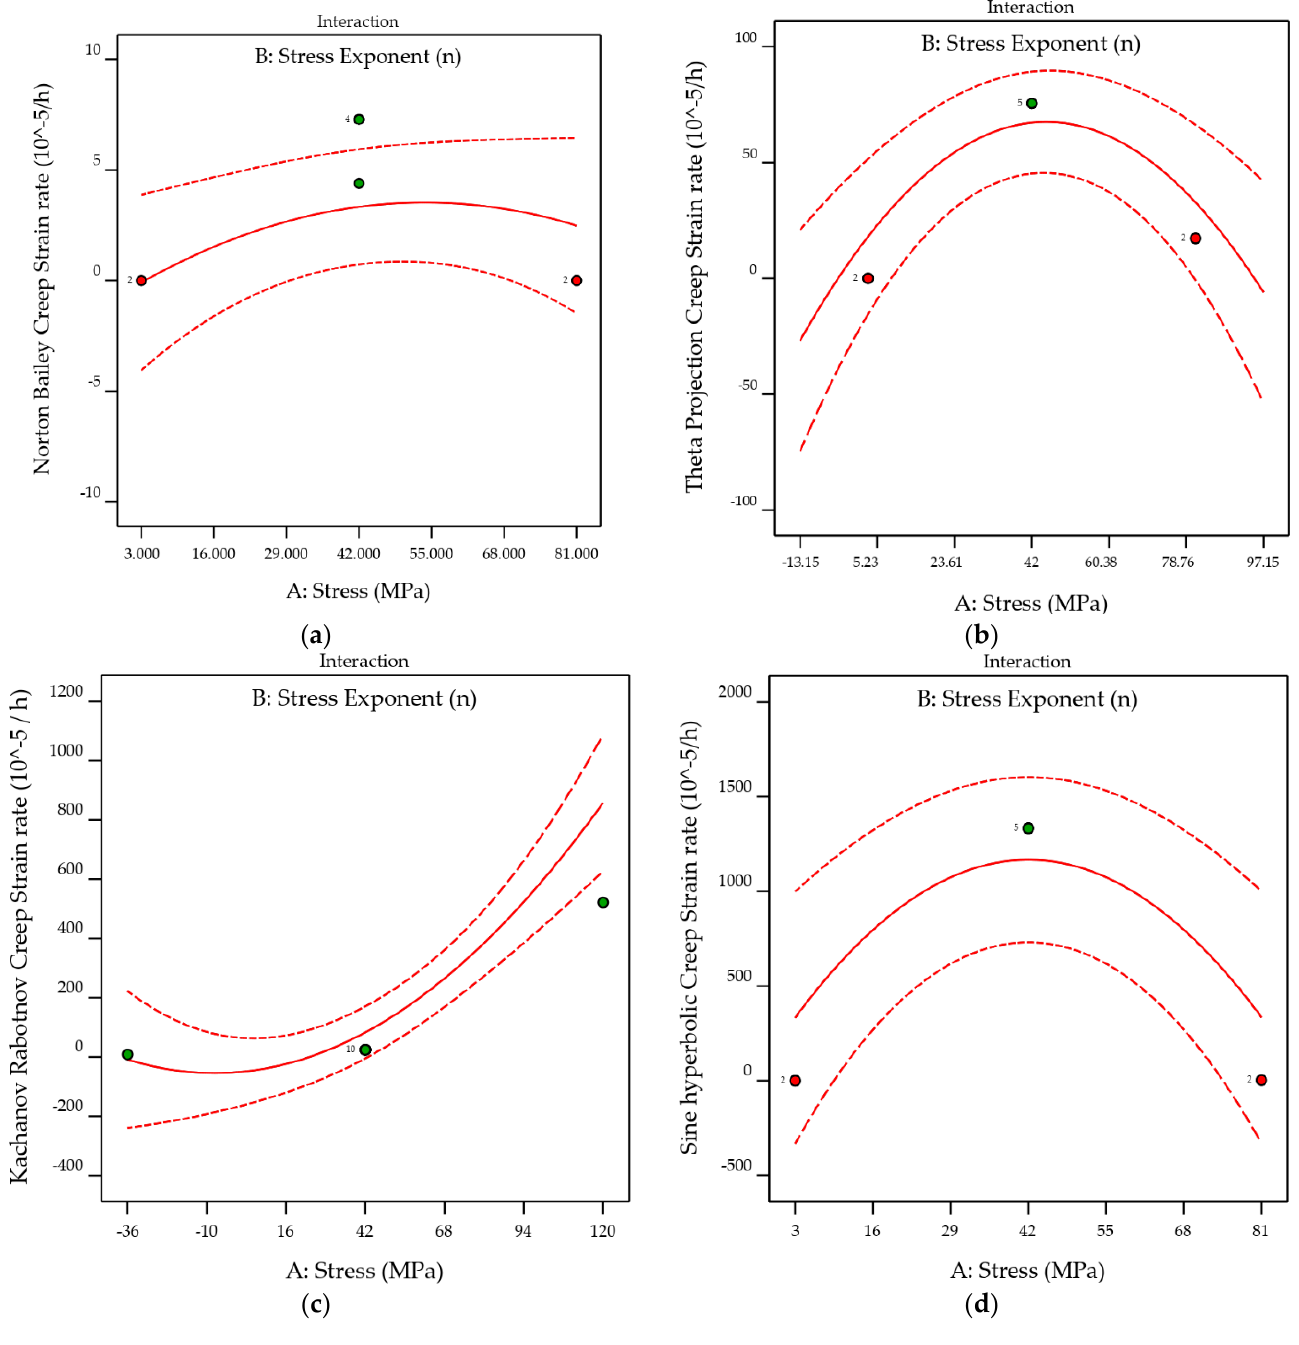
Figure 14. ( a ) Stress and stress exponent interaction effect on NB model’s creep strain rate; ( b ) stress and stress exponent interaction effect on TP model’s creep strain rate; ( c ) stress and stress exponent interaction effect on KR model’s creep strain rate, and ( d ) stress and stress exponent interaction effect on SH model’s creep strain rate.